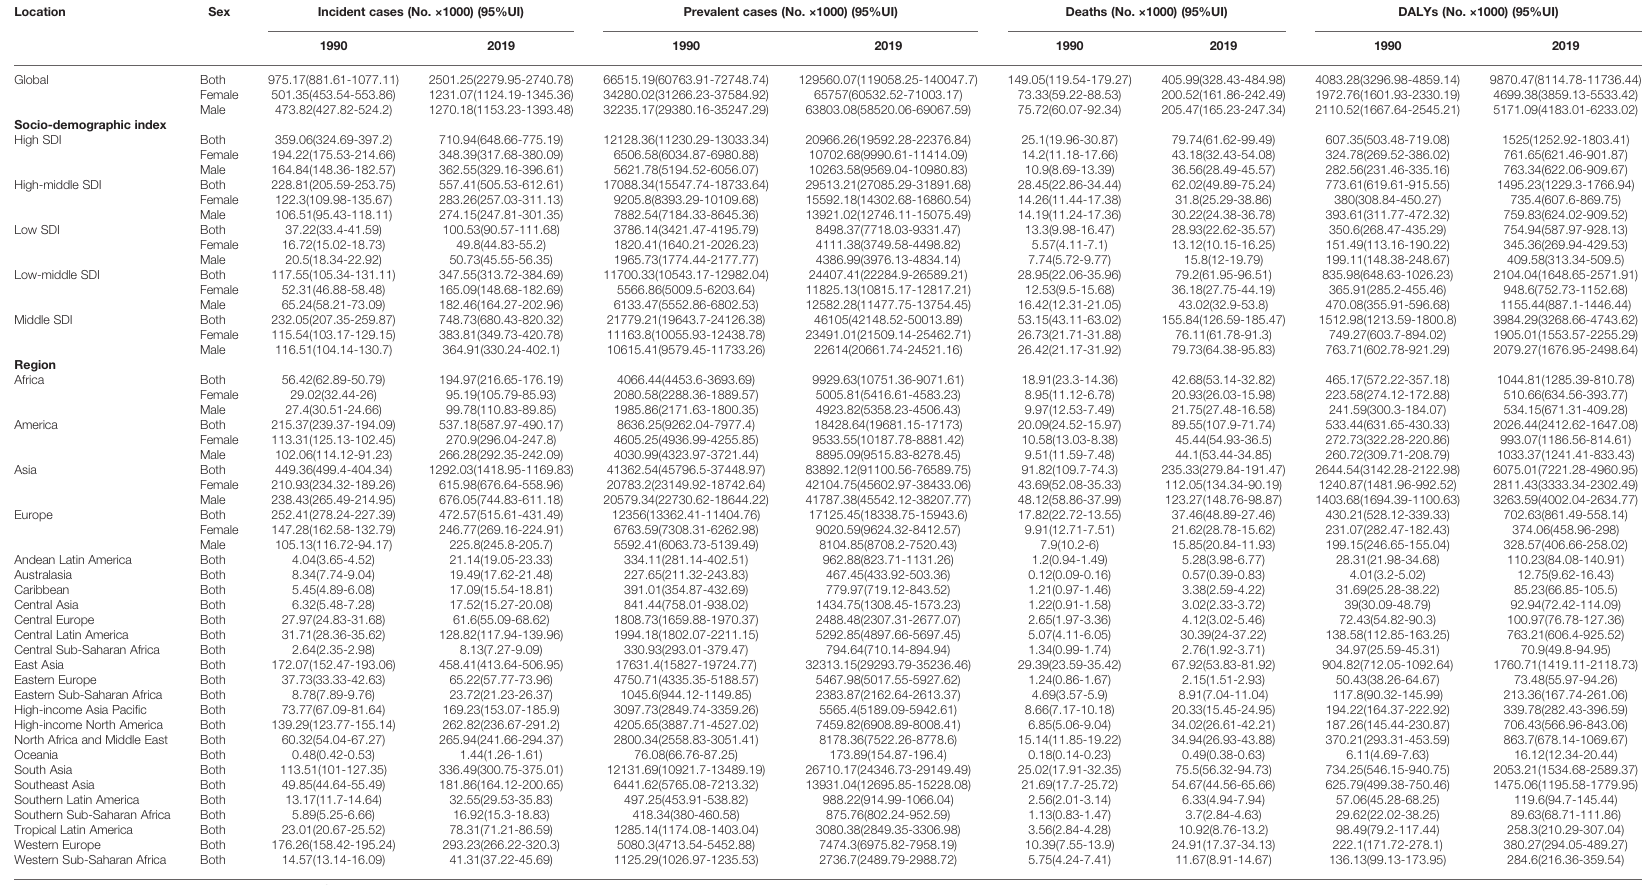
TABLE 1 | The global and regional burden of chronic kidney disease caused by diabetes mellitus type 2.